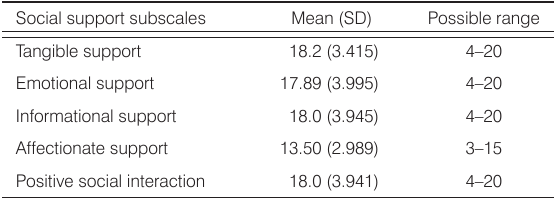
Table 3. Mean (SD) scores of social support subscales.